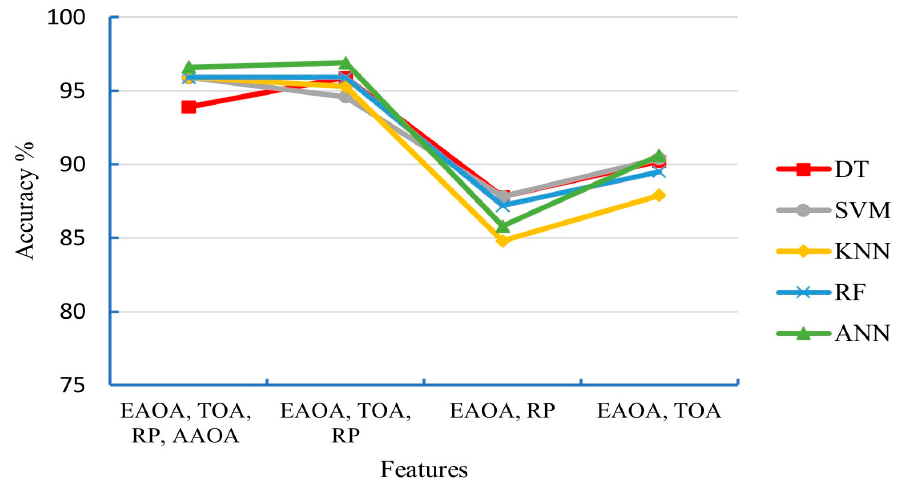
Figure 10. Impact of features selection on the accuracy.